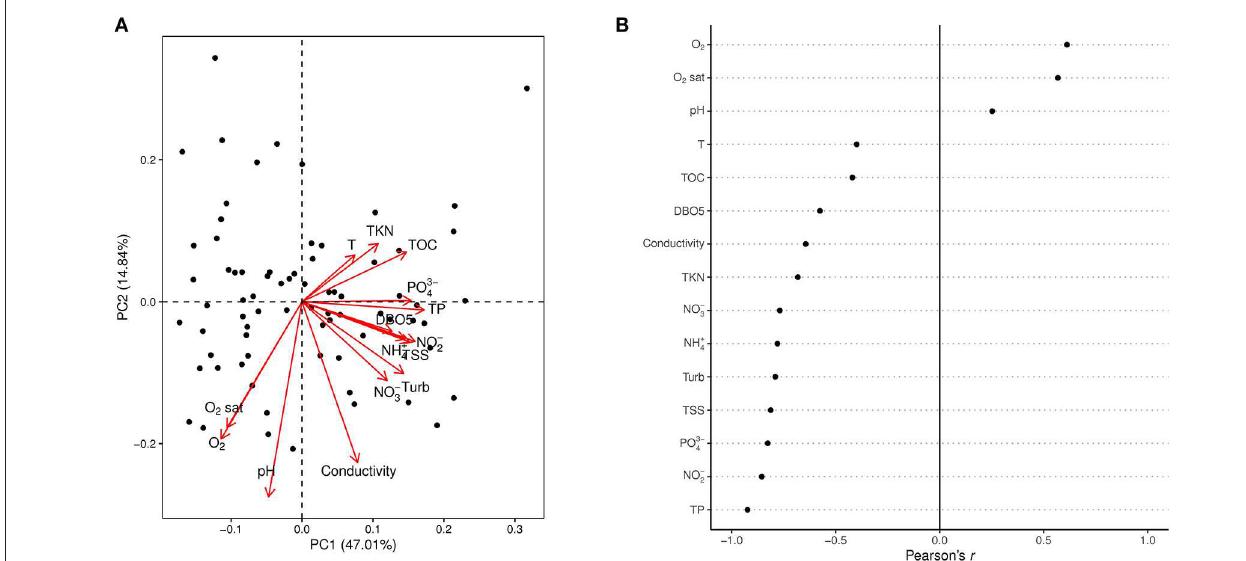
FIGURE 2 | Principal component analysis of the environmental variables. The PCA biplot (A) shows the projection of the sites (black dots) and the variable loadings on the first two principal components (PC1 and PC2). The dotplot (B) indicates the correlation (Pearson’s r) of each environmental variable with the first principal component (PC1) that was used as the reference gradient for the indices. High and low values indicate strong positive and negative correlation respectively, while values close to zero indicate weak correlations between PC1 and the given